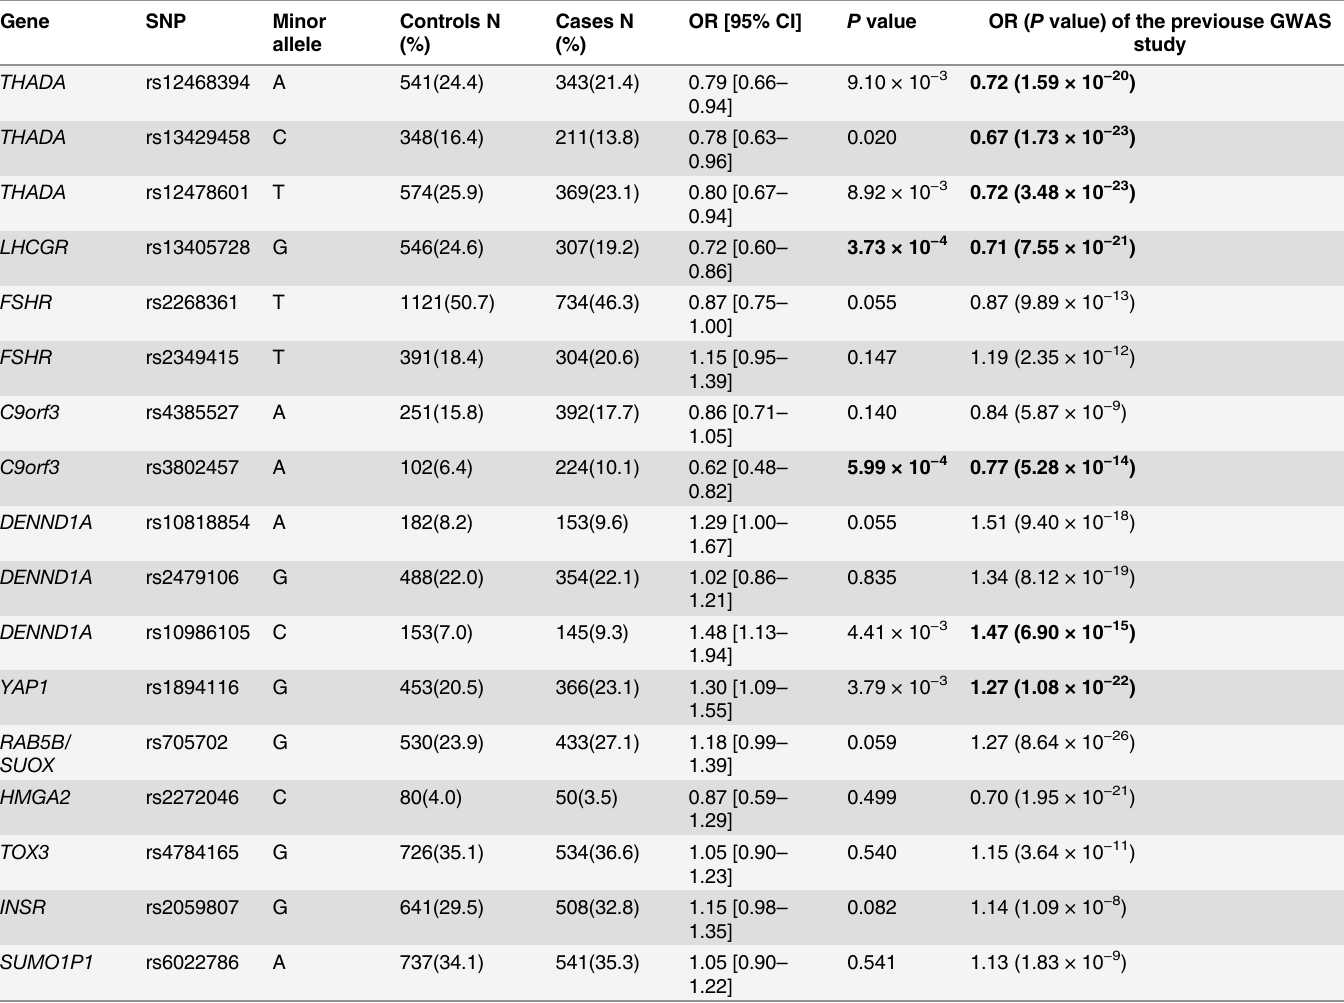
Table 3. Association analysis of previous GWAS risk variants with PCOS, adjusted for